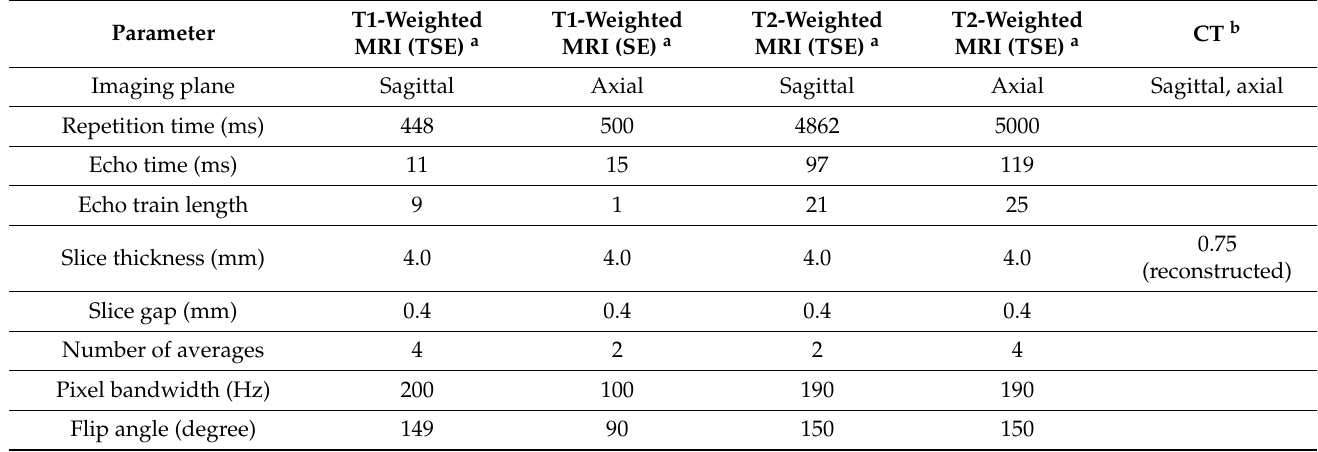
Table 1. Scan and reconstruction parameters for MRI and CT